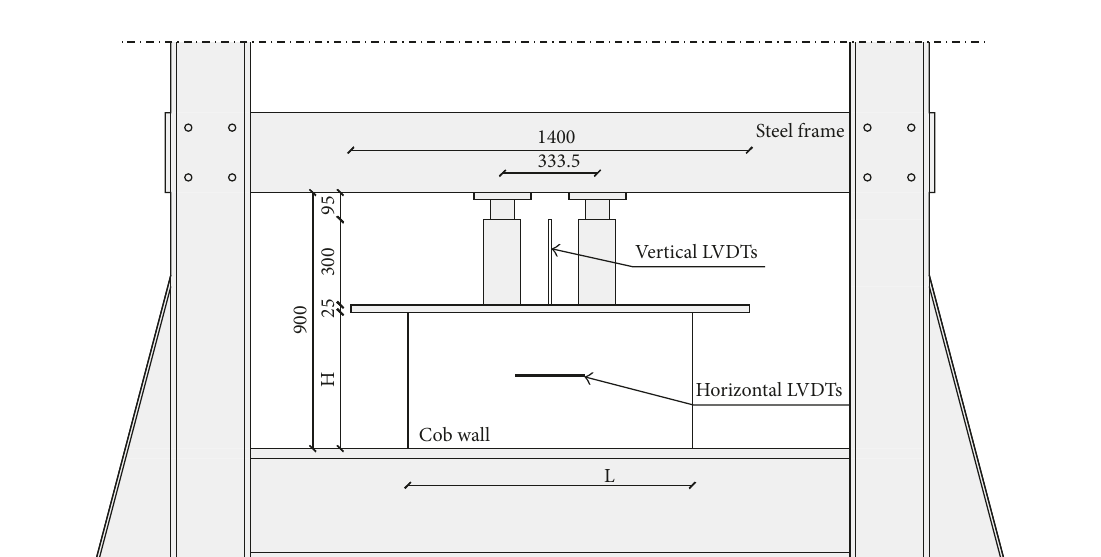
Figure 4: Test apparatus and LVDT placement for each specimen side (measures in